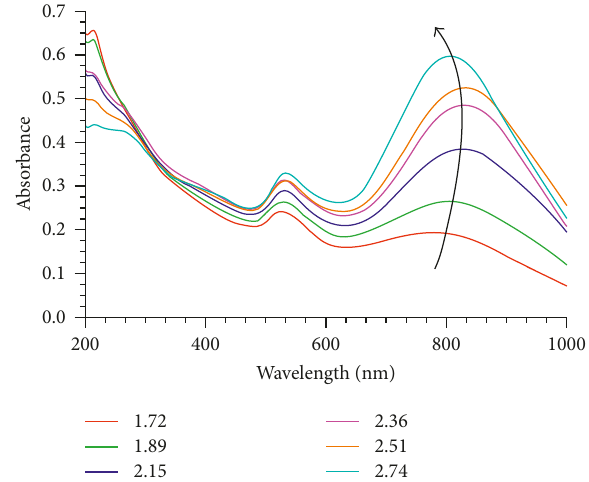
Figure 2: Evolution of the absorbance for several molar ratios R after the synthesis. The curved arrow denotes the stop-and-return tendency of the NIR